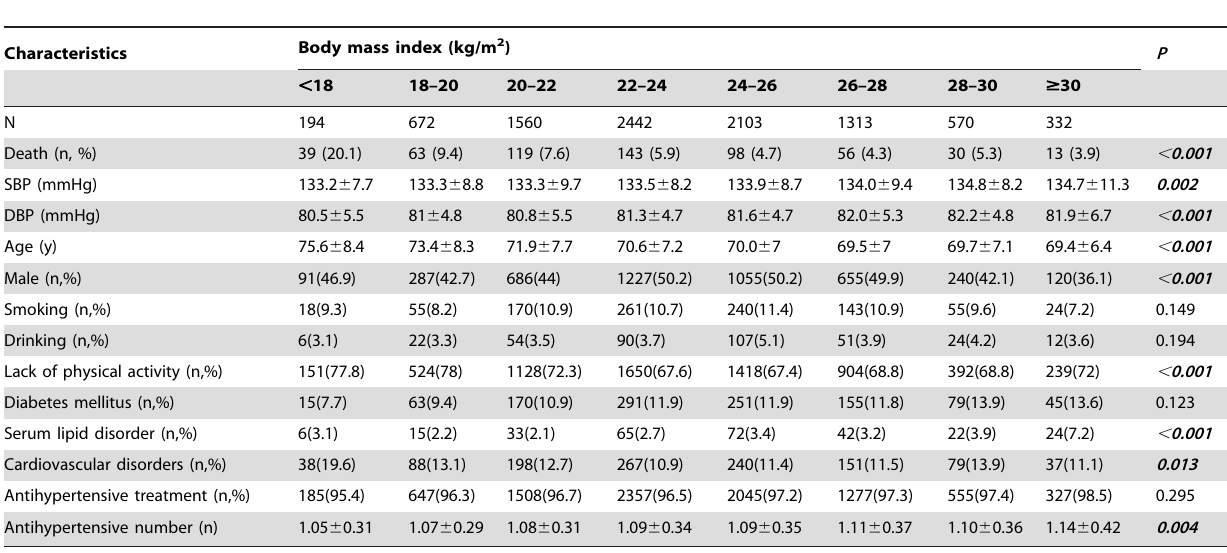
Table 1. Baseline characteristics of the community hypertensive patients by category of body-mass index.